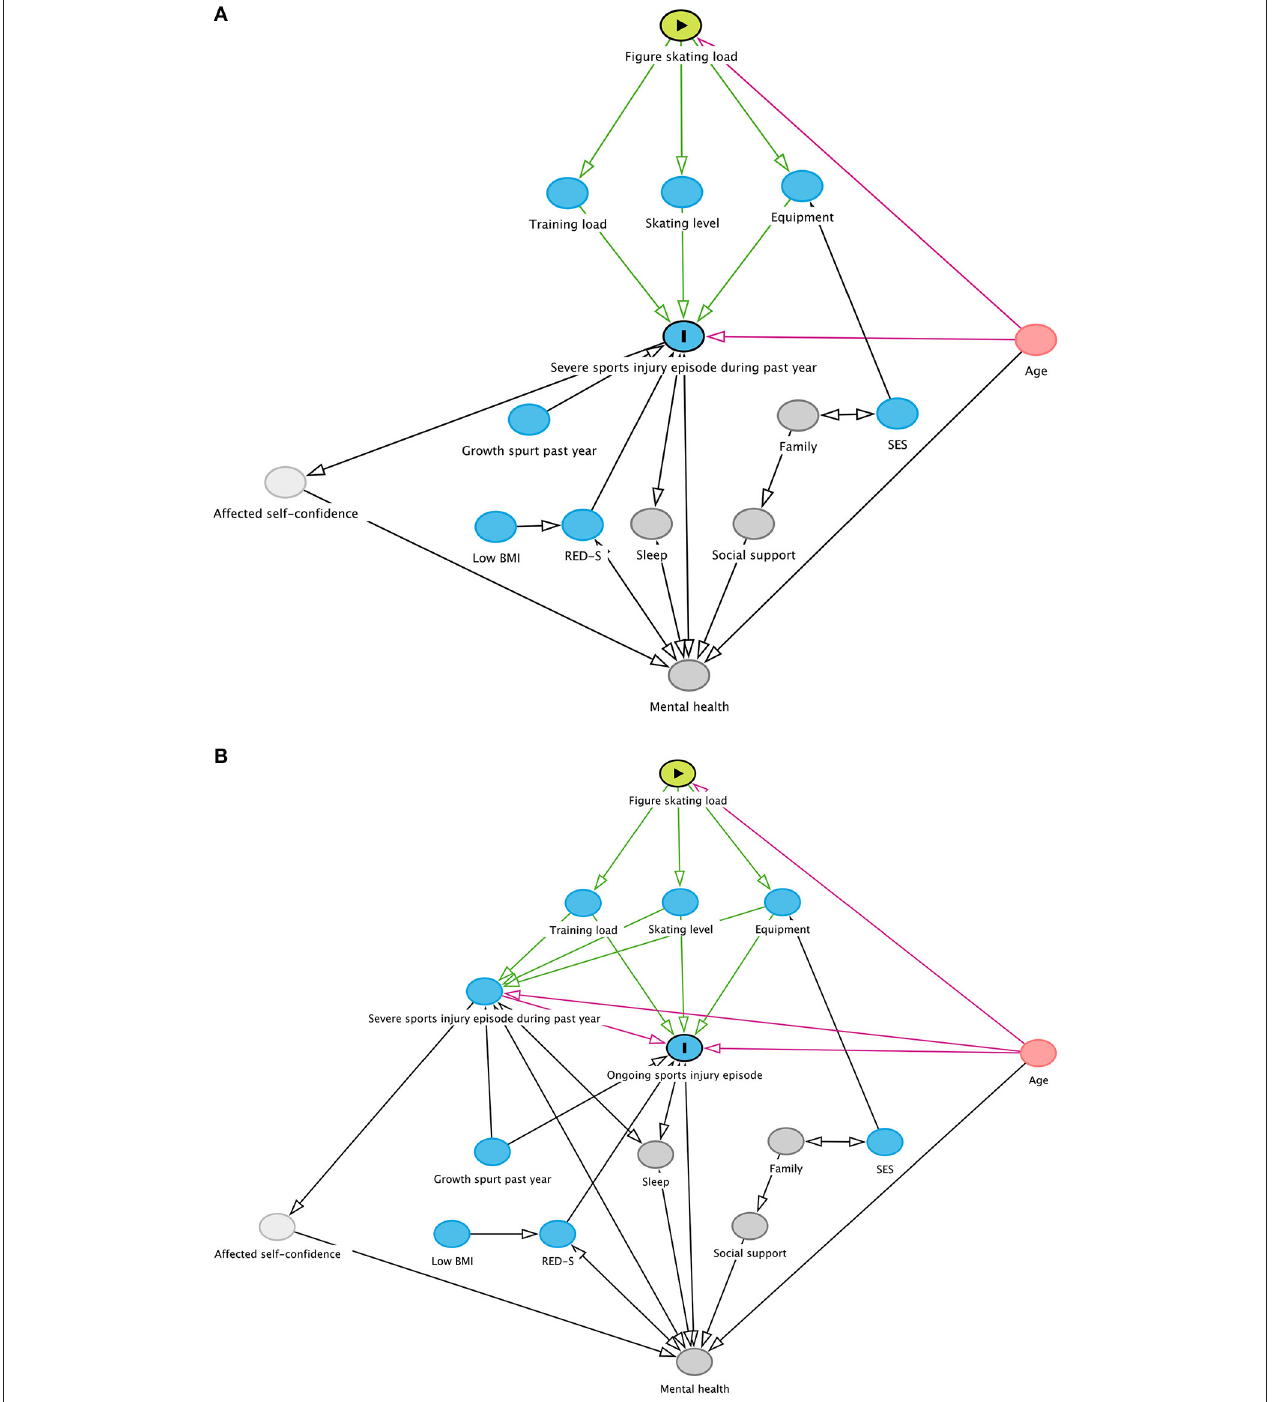
FIGURE 1 | Theoretical representation of health issues in figure skating. BMI, body mass index; SES, socioeconomic status; RED-S, relative energy deficiency in sport; Blue node, outcome and ancestors of the outcome; Green node, exposure; Pink node, ancestor of exposure and outcome; Dark gray node, other variables; Light gray node, unobserved (latent); Green arrow, casual path; Pink arrow, biasing path. (A) Outcome: Severe sports injury episode during the past year. (B) Outcome: Ongoing sports injury episode. Graphs created using DAGitty.